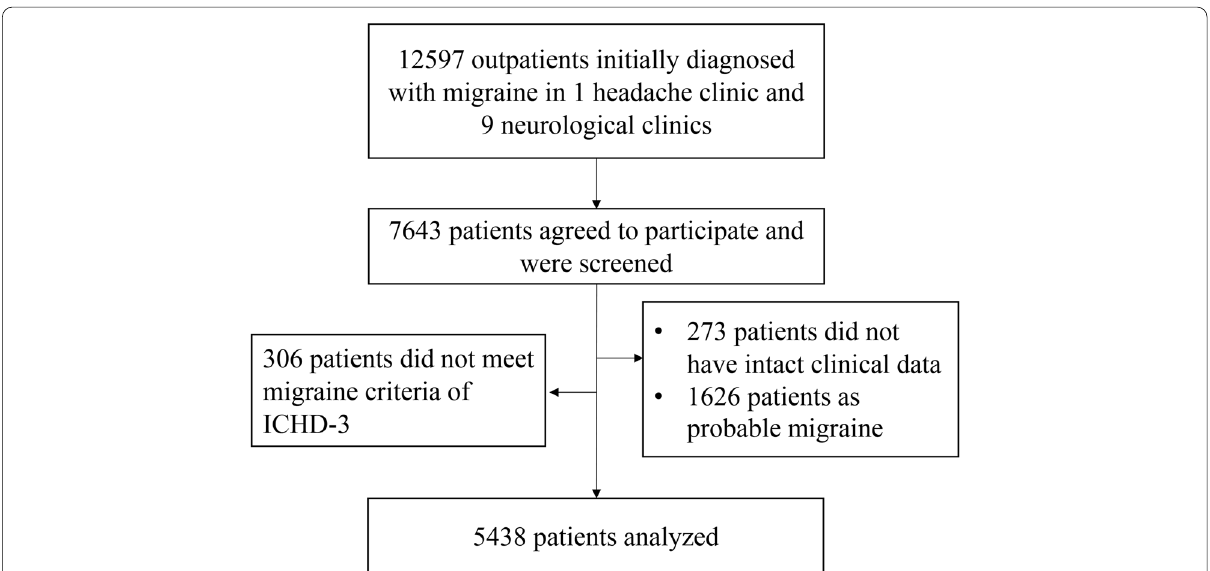
Fig. 1 Flow schematic of participant recruitment and data analysis. From April 2014 to December 2020, we consecutively enrolled 12, 597 migraine patients in 10 headache or neurological clinics, of which 7643 agreed to participate in the study. A total of 412 cases were excluded (306 did not meet the diagnostic criteria of migraine, and 273 did not have intact clinical data) in the data verification process, and 1626 cases who were diagnosed as probable migraine. Ultimately, 5438 patients were included for